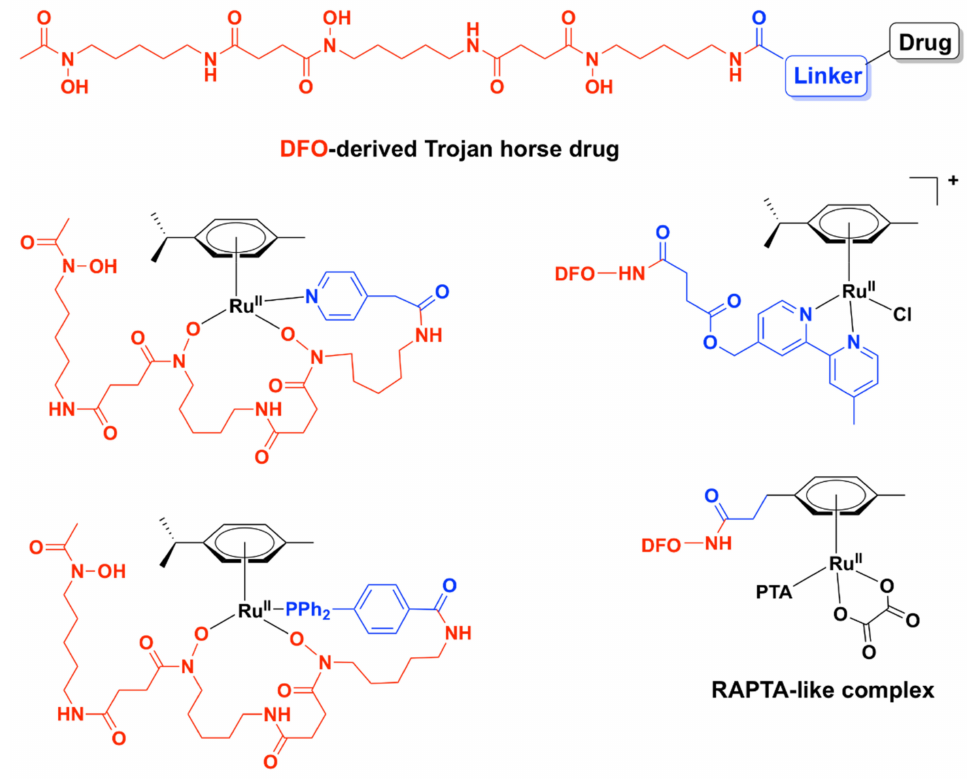
Figure 10. General structure of deferoxamine B (DFO)-derived Trojan Horse antibacterial drugs and some DFO-derived Ruthenium(II)–Arene Complexes